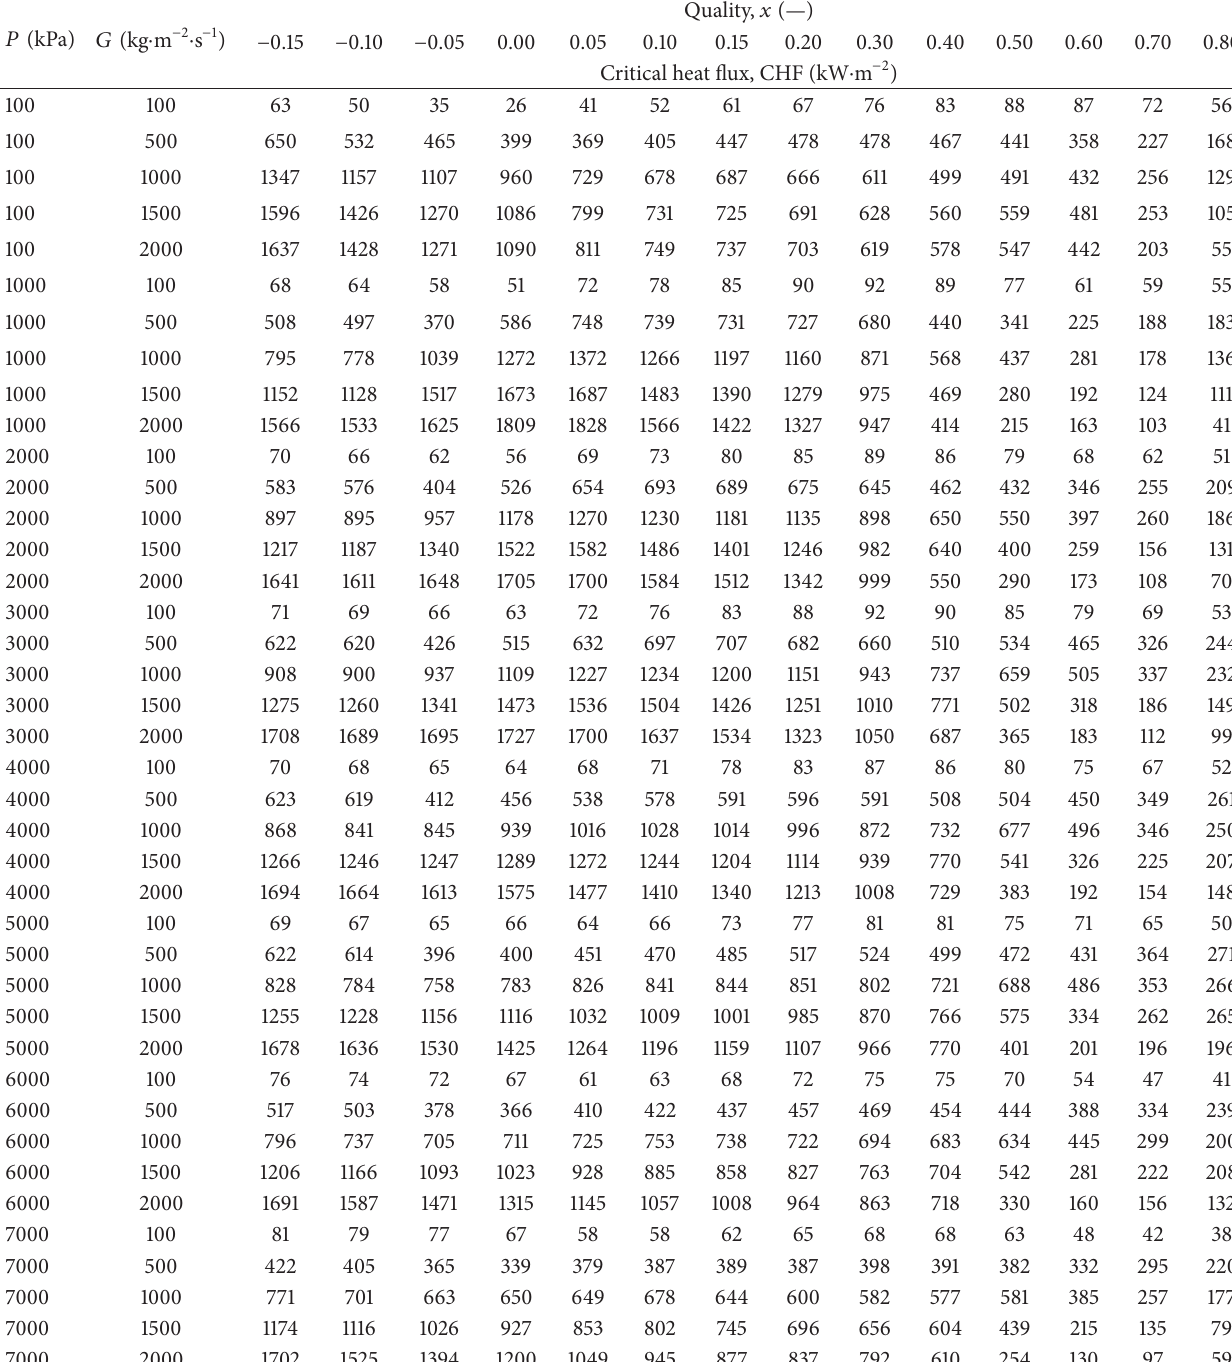
Table 3: CHF-LUT for horizontal flow in 67mm diameter